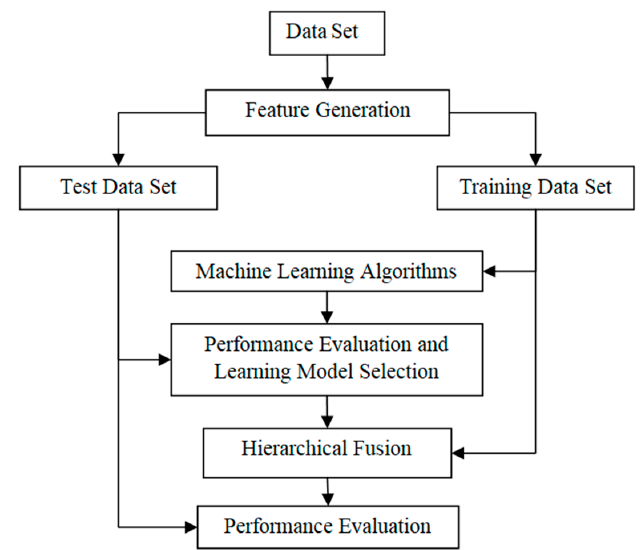
Figure 1. Positioning and localization